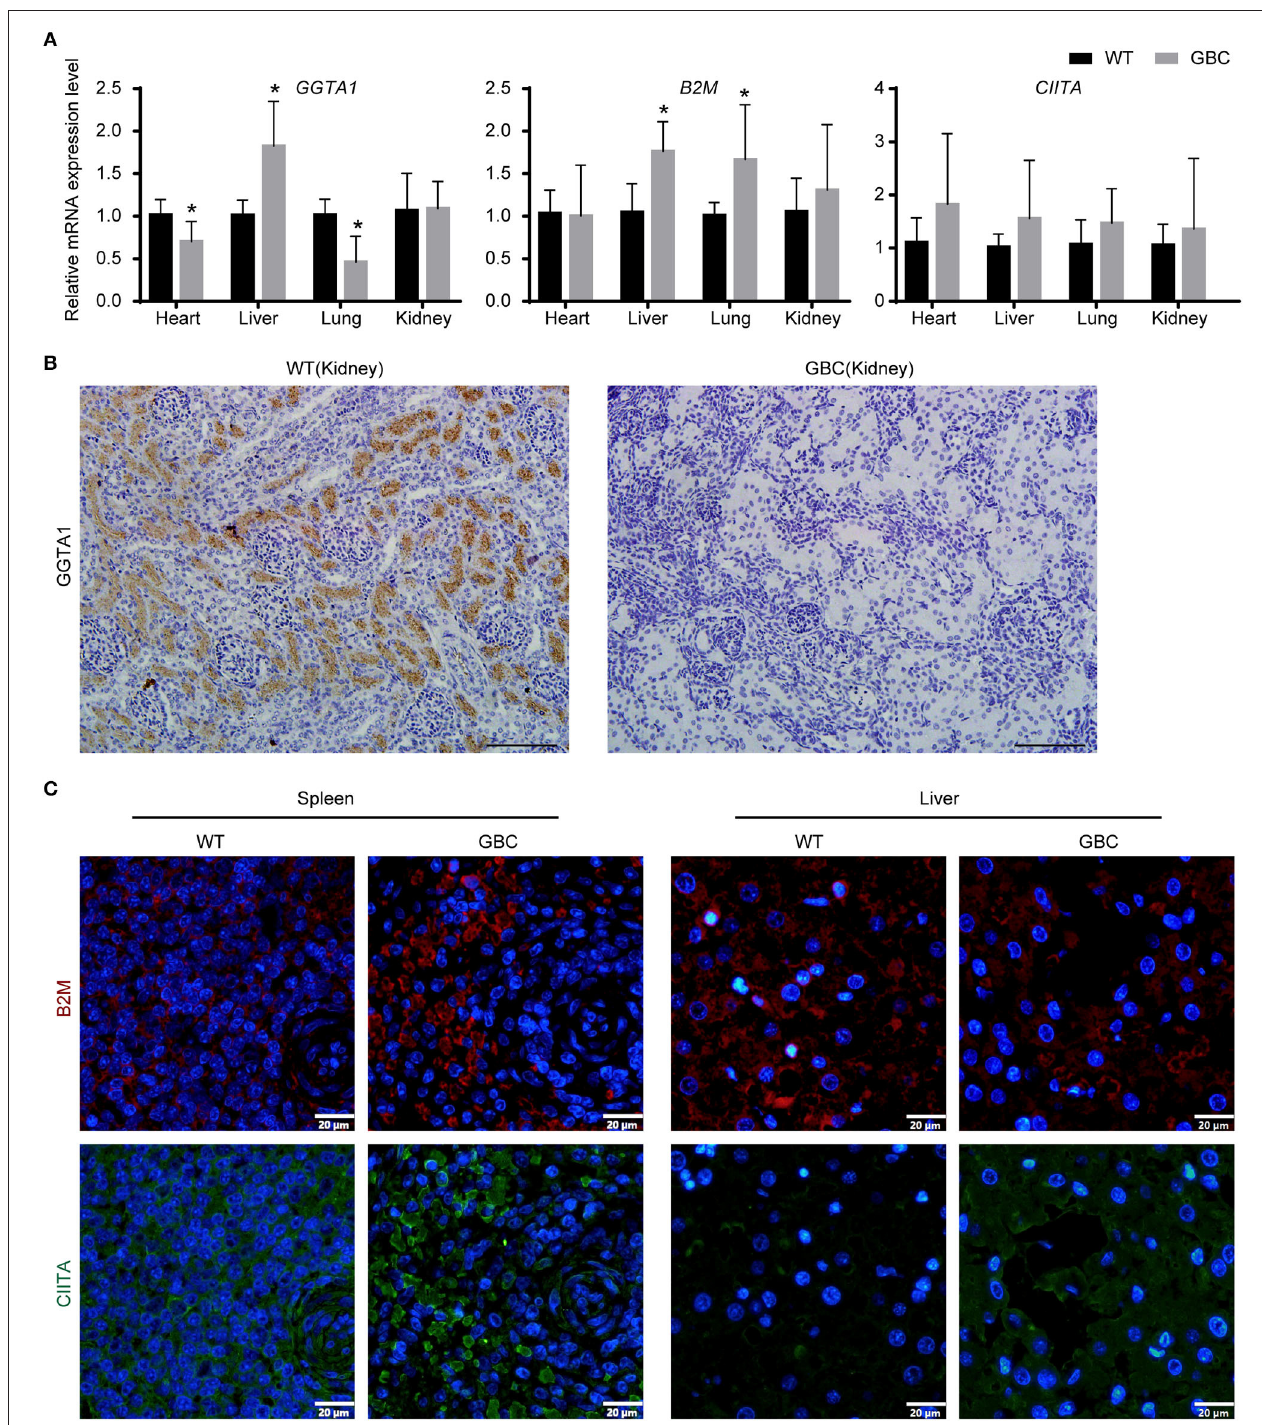
FIGURE 3 | Expression of GGTA1, B2M, and CIITA genes in GBC-modified pigs. (A) The mRNA expression levels of GGTA1, B2M, and CIITA genes in the heart, the liver, the lungs, and the kidney (* P < 0.05 vs. WT). (B) Immunohistochemical staining of α Gal in the kidney (scale bar = 100 µ m). (C) Immunofluorometric analysis of B2M and CIITA proteins in the spleen and the liver (scale bar = 20 µ